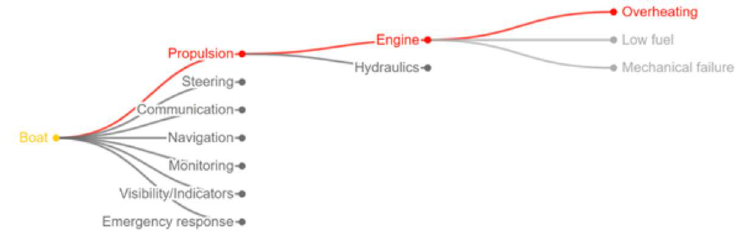
Figure A2. The Health